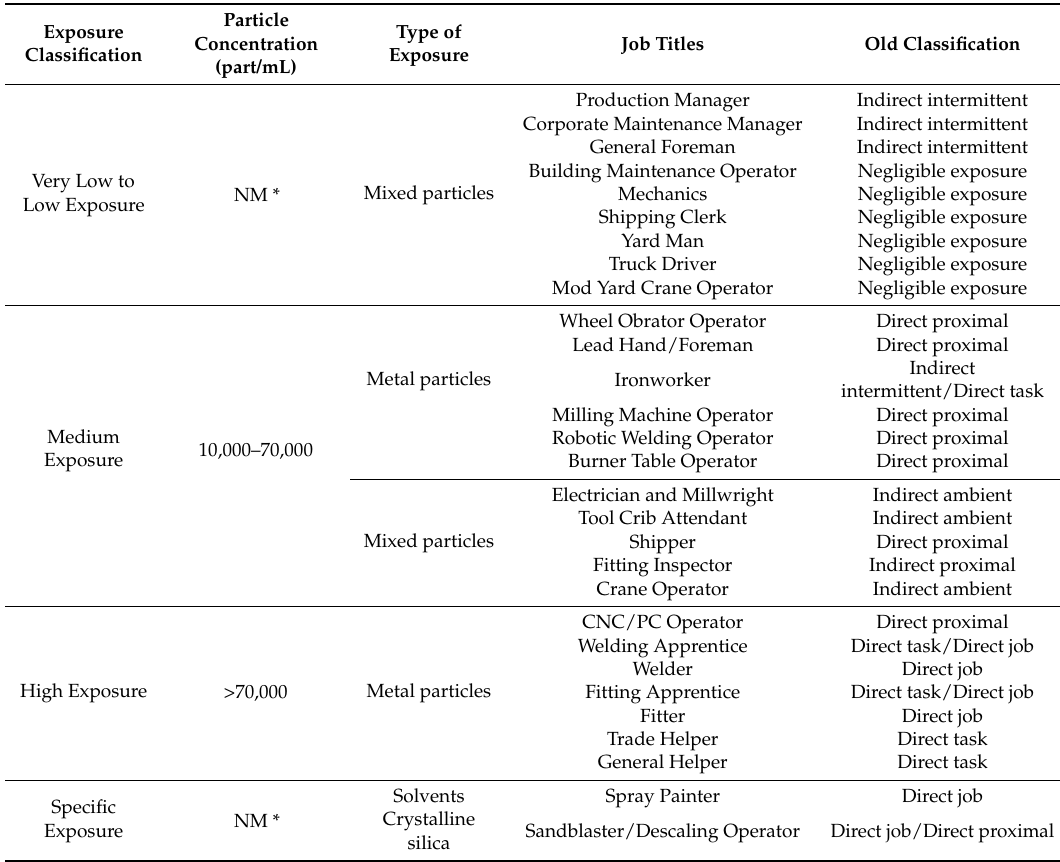
Table 4. Final Similar Exposure